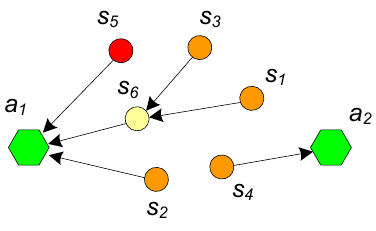
Figure 6. Simulated WSAN